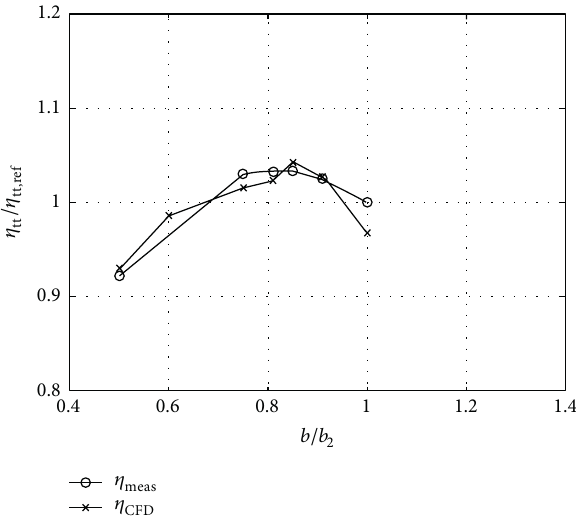
Figure 7: Comparision between measured and simulated stage total-to-total efficiencies. The efficiency for each design is taken at the same mass